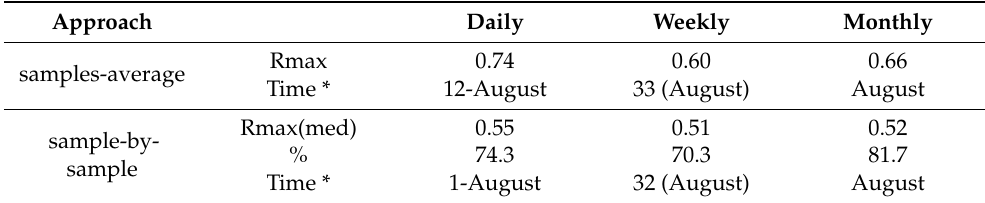
Table 2. Maximum correlation coefficient values between soil moisture and black truffle production obtained in the Iberian Peninsula with the two approaches. For the sample-by-sample approach, Rmax refers to the median (med) values, and the corresponding percentage of R significant ( p < 0.05) values is also included. * Time (day, week or month) at which the maximum value is